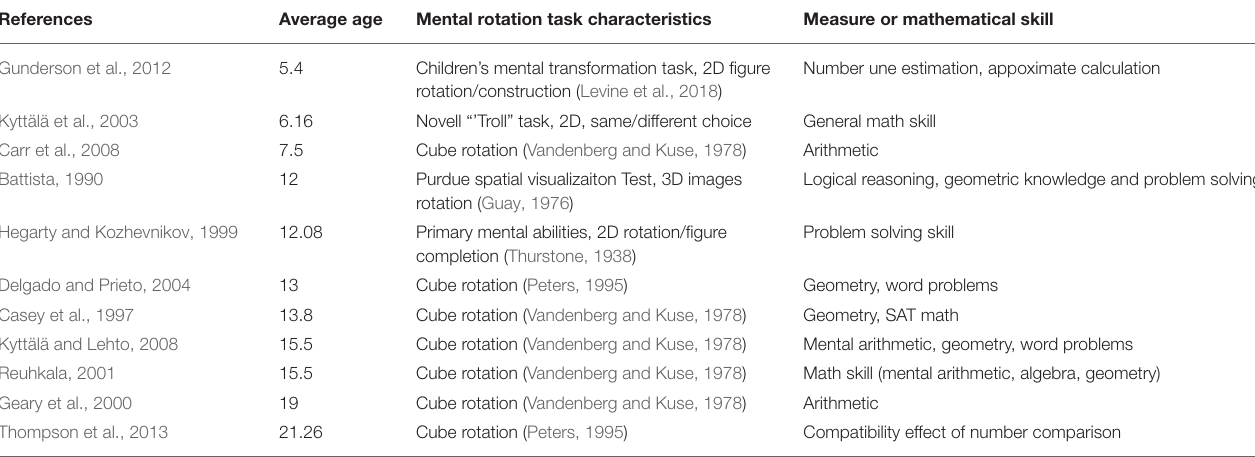
TABLE 1 | Observed relations between mental rotation and mathematical skills.